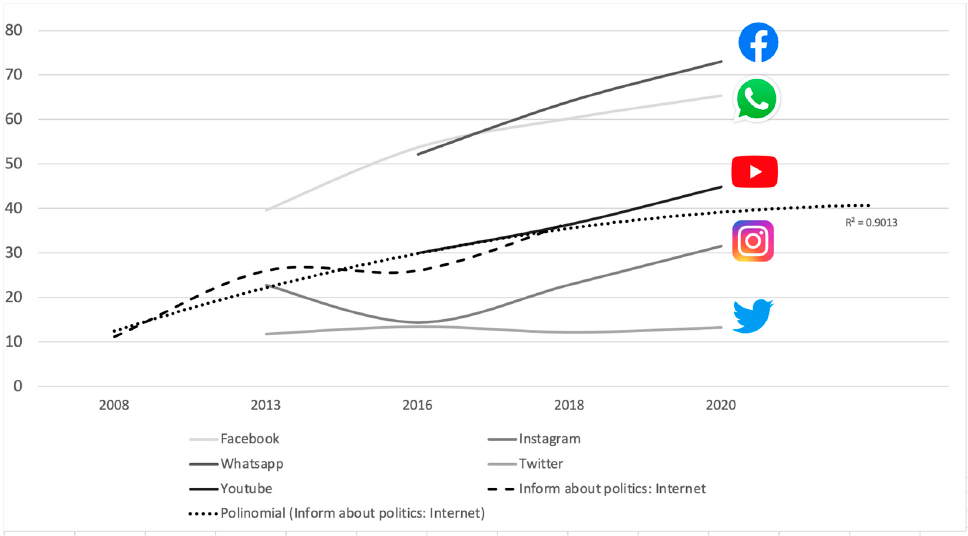
Figure 1. Social networks and online political information-following in Latin America. Source: Latinobarometer (2008–2020).